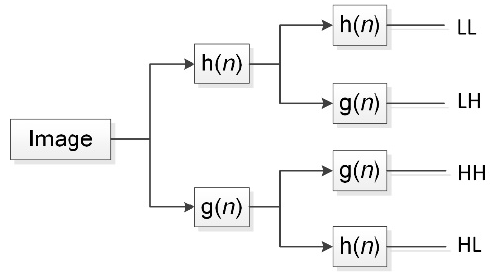
Figure 4. Decomposition of 2D-DWT.